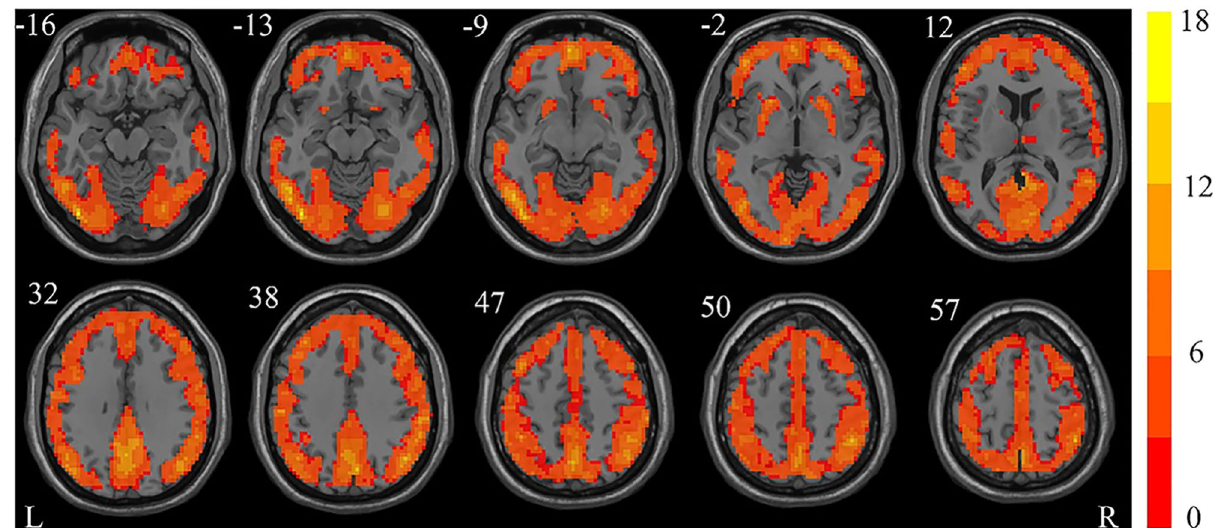
Figure 1. The one-sample t -test results of the healthy control group shown as a Kendall’s coefficient concordance (KCC) map (false discovery rate [FDR] corrected, p < 0.05). The figure was presented using the free DPABI software. Red areas indicate a positive ReHo. The number above each image refer to the z-plane coordinates of the Montreal Neurological Institute space. ReHo regional homogeneity, L left, R